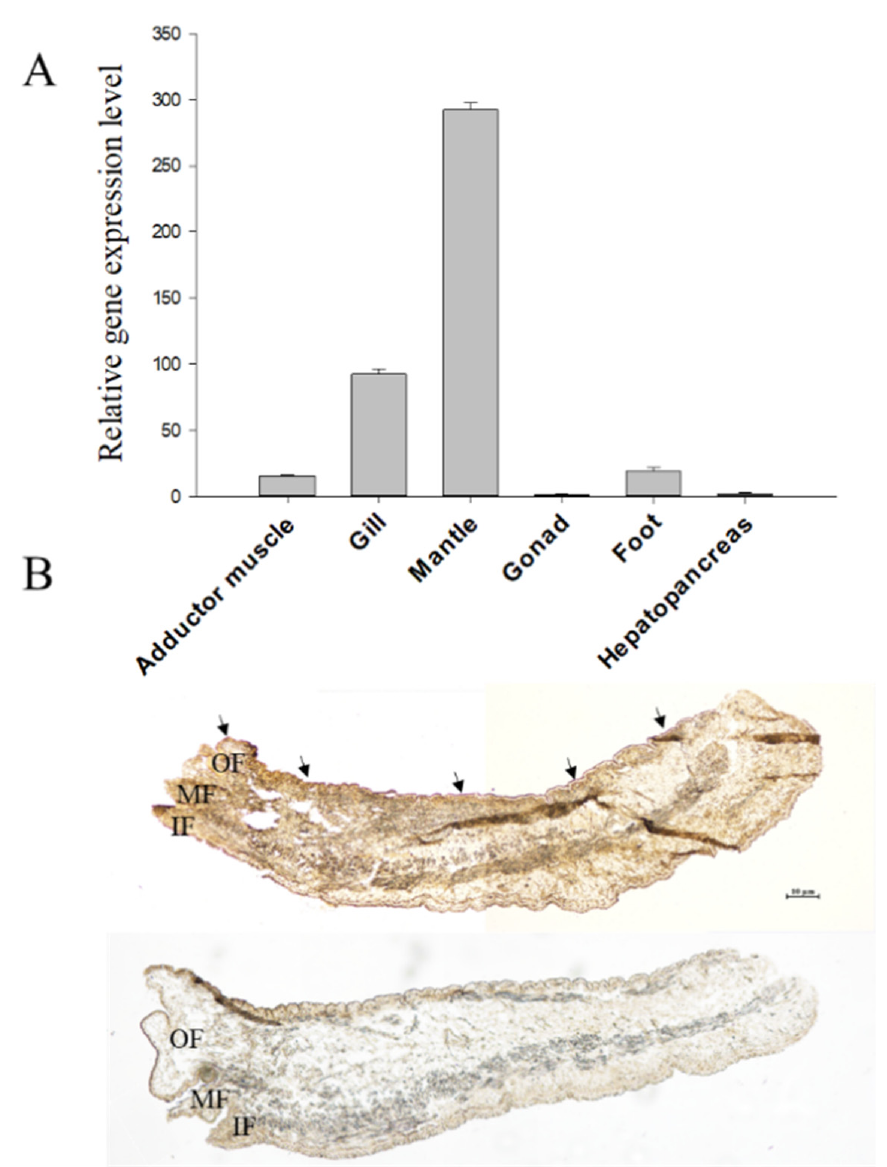
Figure 5. Tissue expression analysis ( A ) and ISH ( B ) results. Note: ( B ), purple hybridization signals were detected in the outer fold epithelial cells of the mantle in the experimental group. OF: outer fold, MF: middle fold, IF: inner fold.